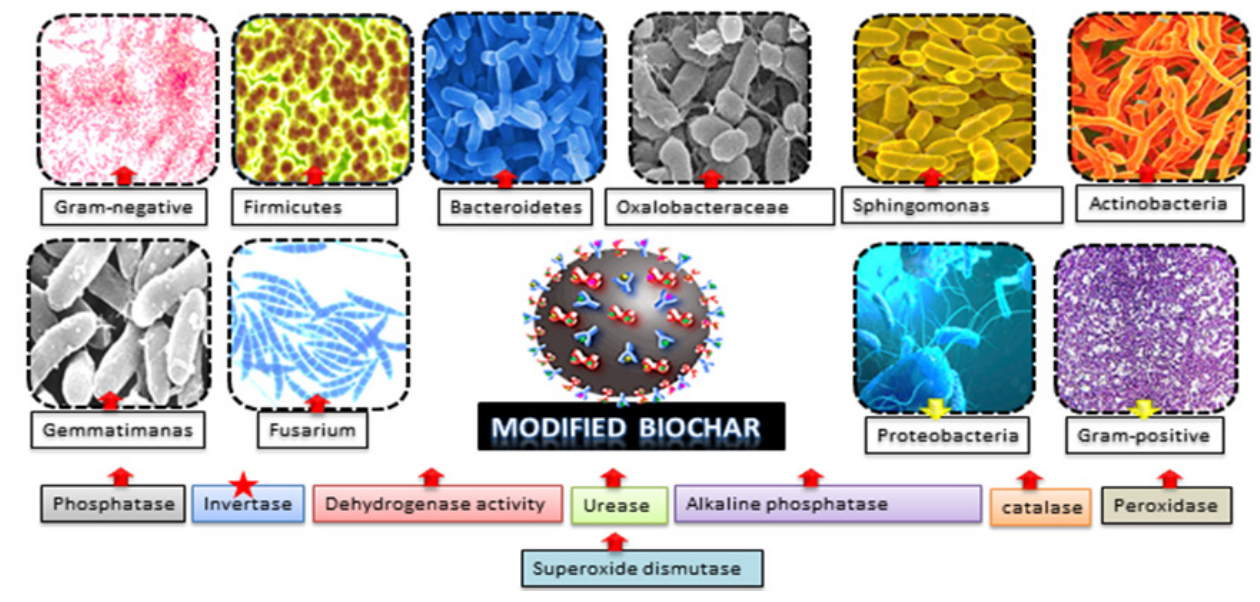
Figure 3. The effect of modified biochar on soil microbial community and enzymatic activity. The red arrows highlight the increase in activities, while yellow arrows show a decrease in specific activity. The star mentioned the non-significant changes.